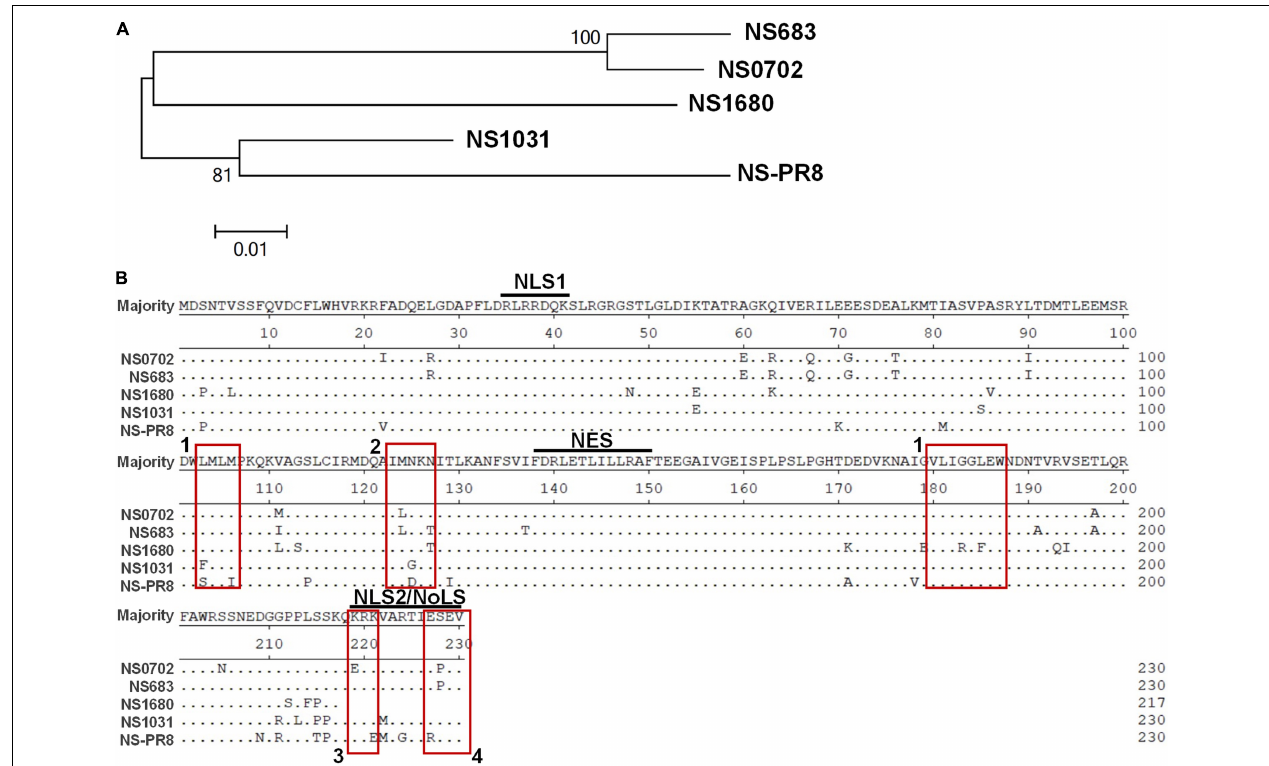
FIGURE 1 | Sequence analysis of influenza virus non-structural protein 1 (NS1) proteins. (A) Phylogenetic analysis of NS1 proteins of several avian influenza viruses, including the NS1 from subtype H6N1 (NS0702), one LPAI H5N2 (NS683), two HPAI H5N2 (NS1680 and NS1031), and one human H1N1 (NS-PR8). (B) Sequence alignment indicated variations at residues responsible for interactions with cellular protein CPSF30 (box 1), protein kinase R (PKR) (box 2), SUMO-1 (box 3), and a PDZ-binding domain (box 4), as well as two sets of nuclear localization signals (NLS), the nucleolus localization signal (NoLS), and nuclear exportation signal